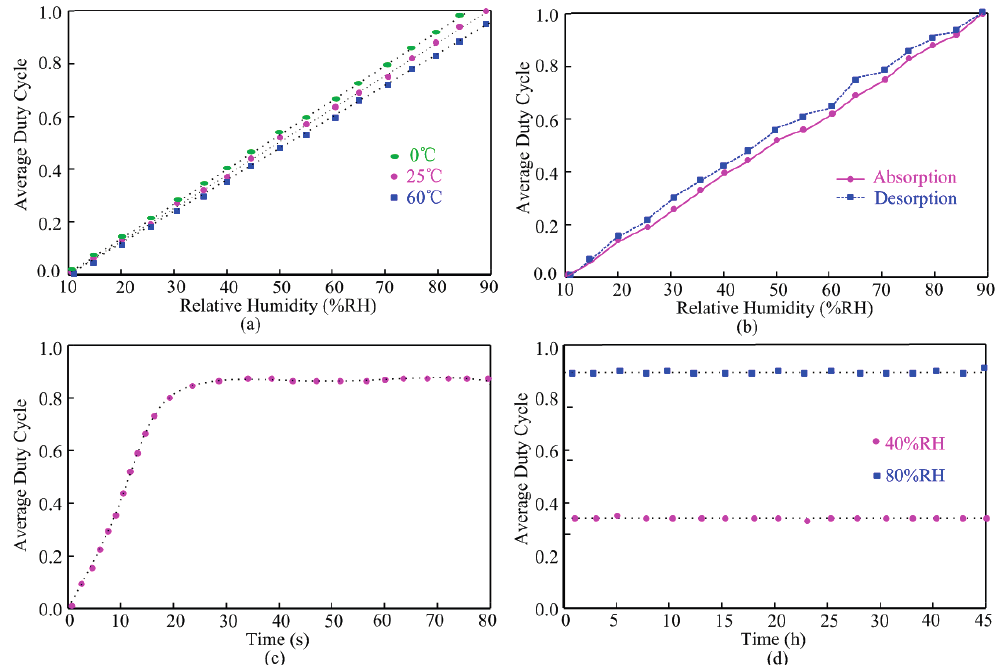
Figure 8. Measured humidity sensor performance: ( a ) linearity; ( b ) hysteresis; ( c ) response time and ( d )